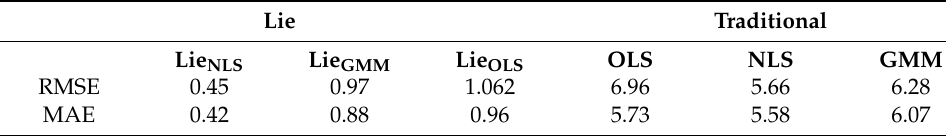
Table 6. Out-of-sample forecast results. Lie NLS Lie GMM Lie